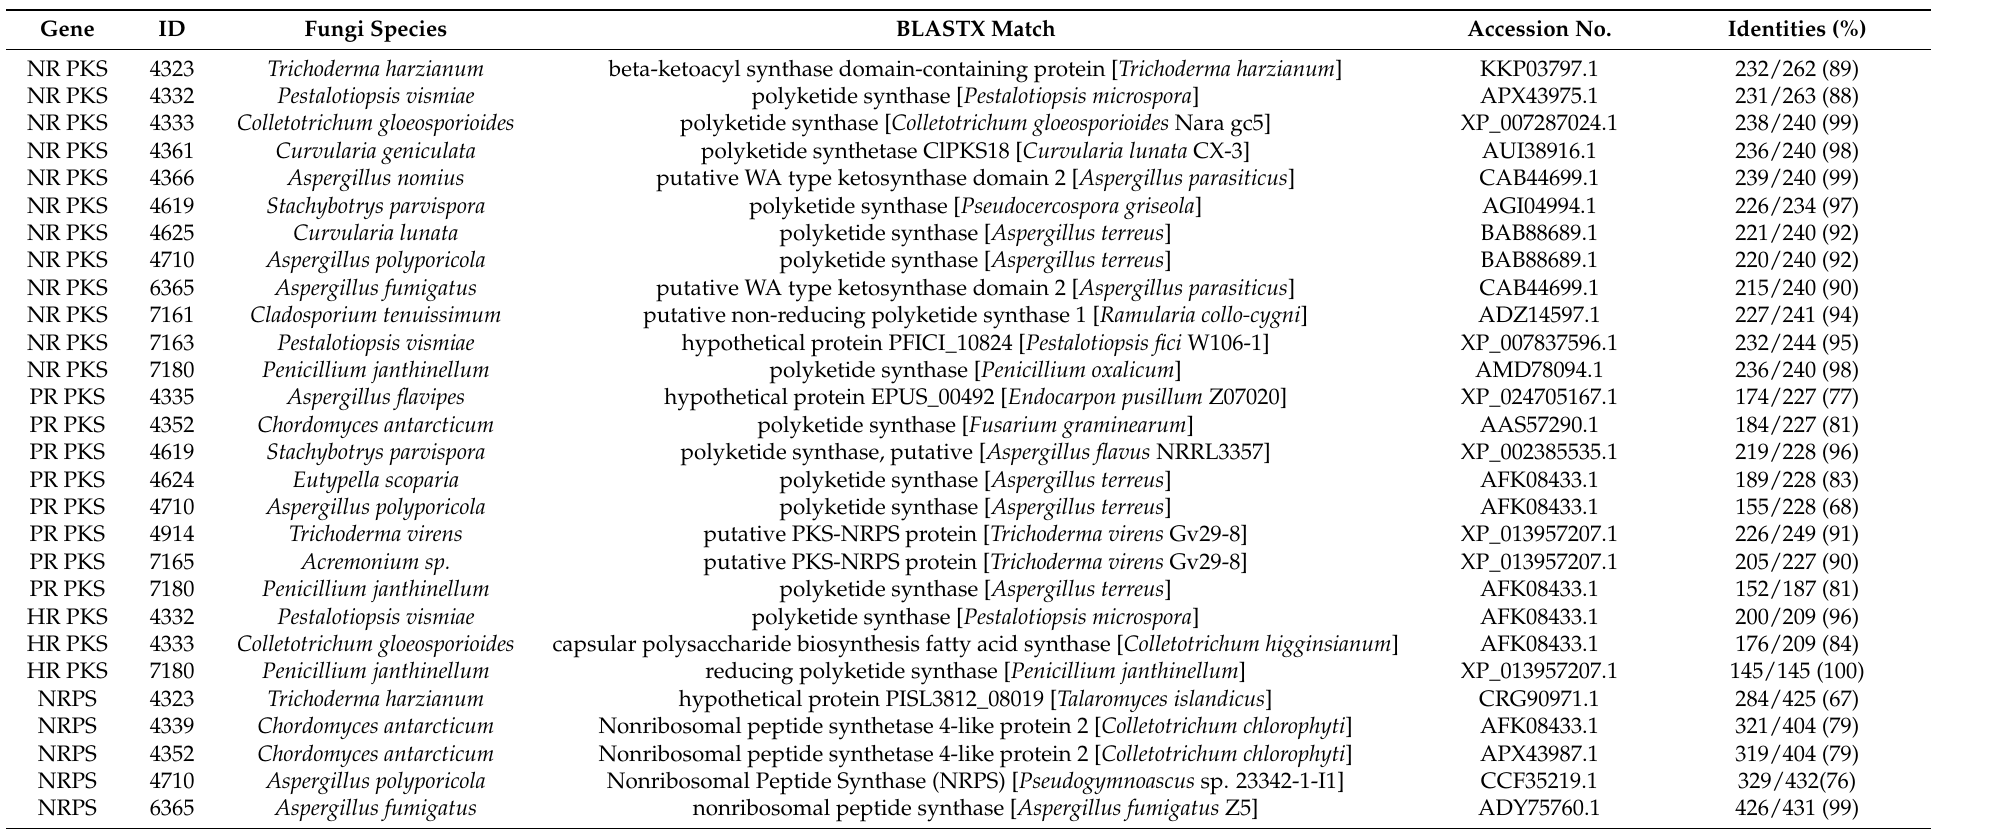
Table 1. PKS and NRPS identified with the degenerate primers. BLASTX matches with the highest scoring annotated protein sequence from NCBI are